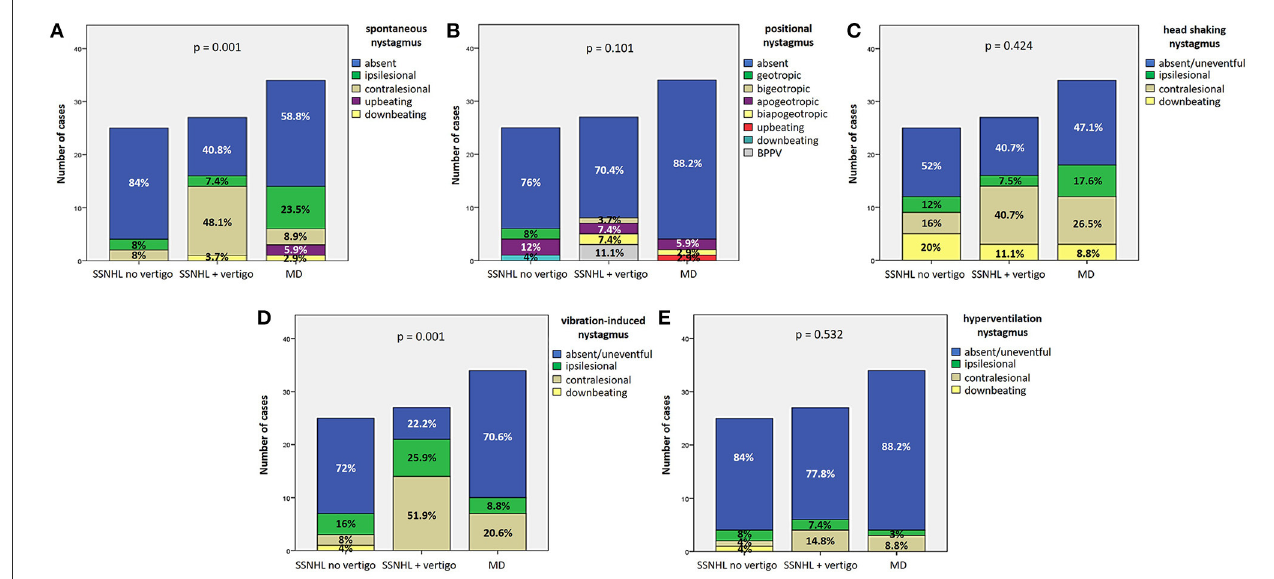
FIGURE6 Bar plots showing the different distribution of the features of spontaneous (A) , positional (B) , head shaking (C) , vibration-induced (D) , and hyperventilation nystagmus (E) among different subgroups based on clinical course. Relative percentages are reported in each column and p -values of categorical comparisons are reported. MD, Menière’s disease; SSNHL, sudden sensorineural hearing